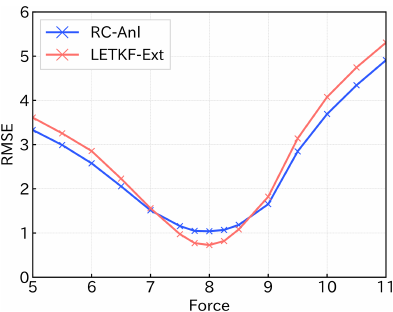
Figure 10. The mRMSE(80) of the predictions of LETKF-Ext(red) and RC-Anl(blue) for each model bias. Horizontal axis shows the value of the force parameter of Eq. (1) (8 is the true value) and vertical axis shows the value of mRMSE. Figure 11. The mRMSE time series of the predictions of RC-Anl